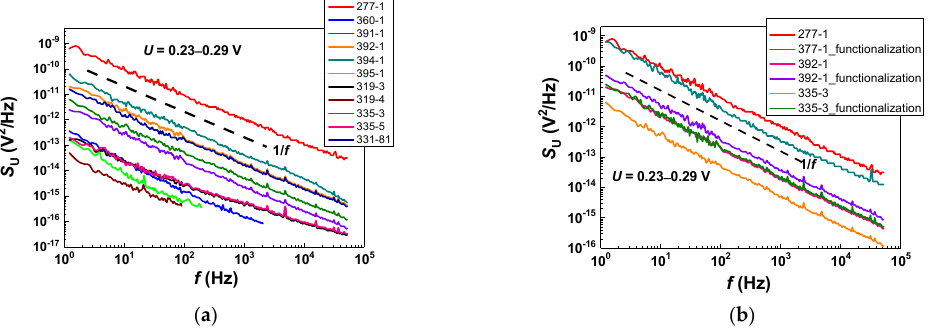
Figure 3. Low-frequency noise spectra of graphene chips before ( a ) and after ( b ) functionalization. Dashed lines indicate a simulation of the 1/f dependence for references. All the chips exhibited a honeycomb like structure typical of graphene films formed on the Si-face of silicon carbide [27]. Local bright areas of small lateral sizes and heights distributed non-uniformly over the graphene surface were observed on all chips (Figures 4 and 5). These are similar to large inclusions identified as a bilayer graphene in Figure 2 and are only just visible in small AFM scans 2 × 2 μ m 2 . The Group 2 chips had a rather higher AFM profile, up to 10–15 nm, and inclusions occupied a larger area (Figure 5) than the Group 1 chips (Figure 6). The height of the AFM profile in the bright areas in Figure 6 is less than 6 nm. ( a ) ( b ) Figure 4. Topography of the graphene surface for chip EG392-1 from Group 2 before functionalization. ( a ) AFM image of the surface with bright areas. ( b ) AFM profile of the graphene surface along the dashed line in ( a ), showing the characteristic arrangement of the nanomaterial of the surface. Bright areas are equivalent to peaks with large magnitude on the profile curve.